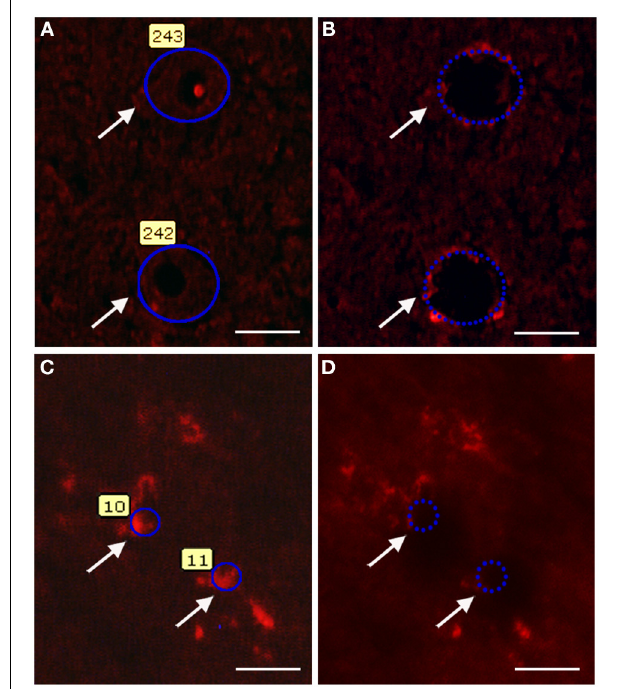
FIGURE 1 | Photomicrographs illustrating motor neuron (A,B) and Schwann cell (C,D) laser microdissection process. The quick ChAT and S100 β immunofluorescence procedures allow recognizing the motor neuron (A,B) and Schwann cell (C,D) profiles (arrows). Profiles were then selected for microdissection (A,C) . After laser firing and microdissection, selected cell profiles (arrows) can no longer be visualized in the tissue (B,D) . Scale bars: 20 μ